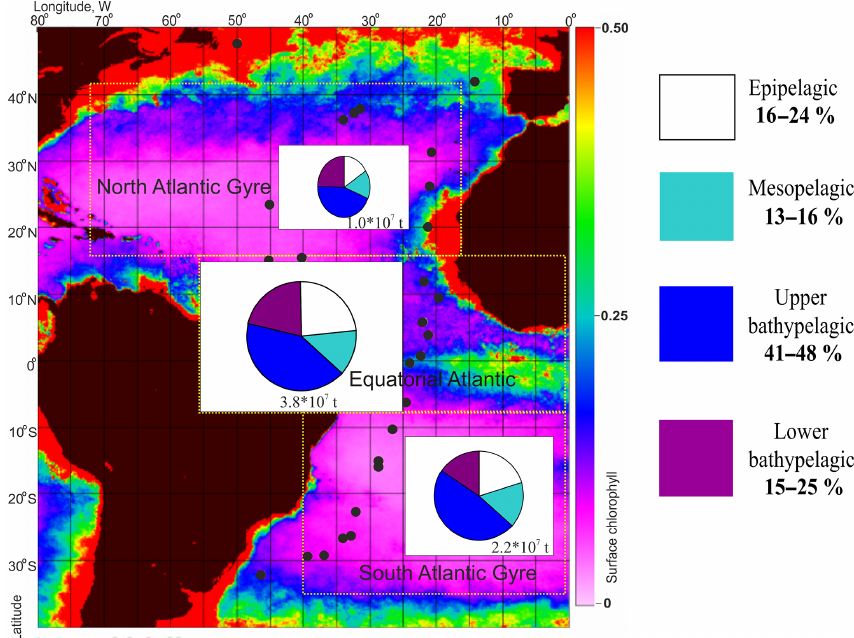
Figure 6. The standing stock (wet biomass) of the deep-sea plankton and contribution (%) of vertical zones in the North, equatorial, and South Atlantic. Background: surface chlorophyll a concentration averaged over 2013; scale (mgm − 2 ) given on the right. Black circles: